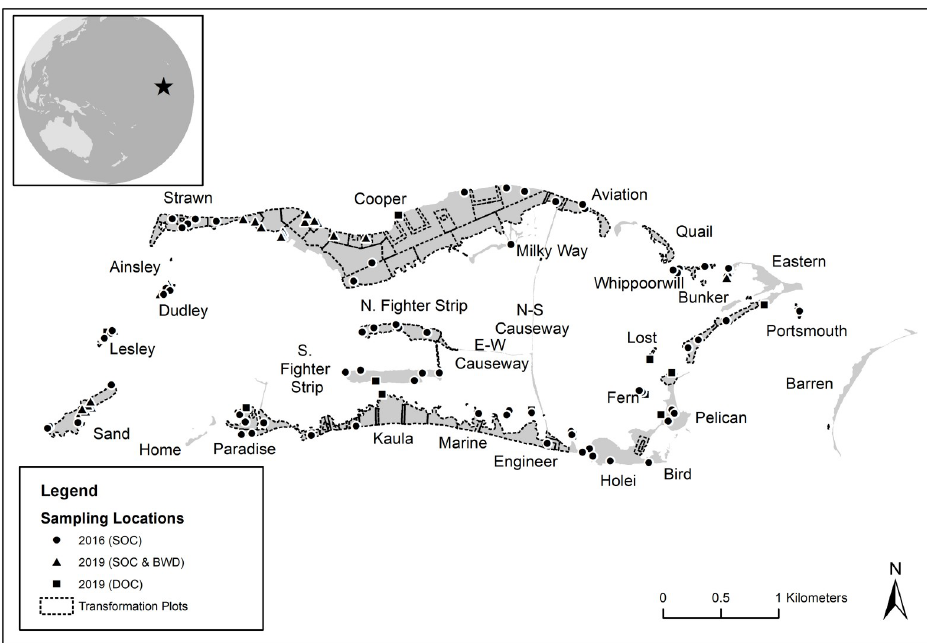
Fig 1. Map of study area at Palmyra. Sampling locations and years are provided for soil organic carbon (SOC), basic wood density (BWD) and dissolved organic carbon (DOC). Transformation plot boundaries are also depicted. Basemap data depicting Palmyra Atoll islet locations are made available in the public domain from the USGS [9]. Global reference map in the inset is made available in the public domain from Natural Earth.